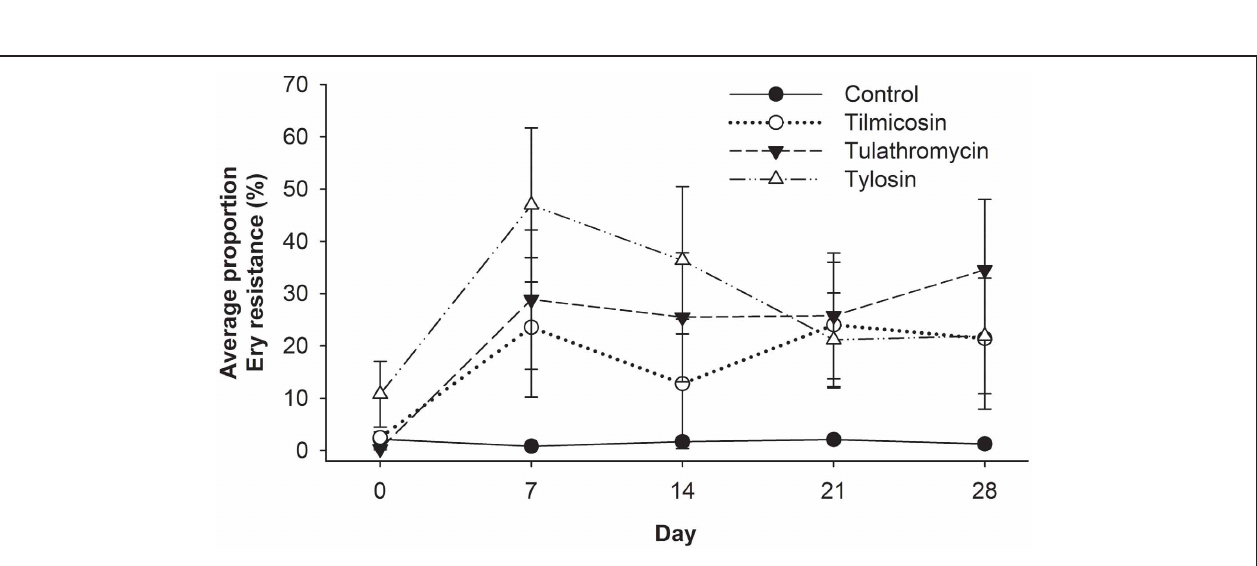
onward, Control isolates had less resistance detected ( P < 0 . 05) than antibiotic treated groups, while resistance noted with injectable macrolides (tilimicosin and tulathormycin) did not differ from that cattle fed tylosin.